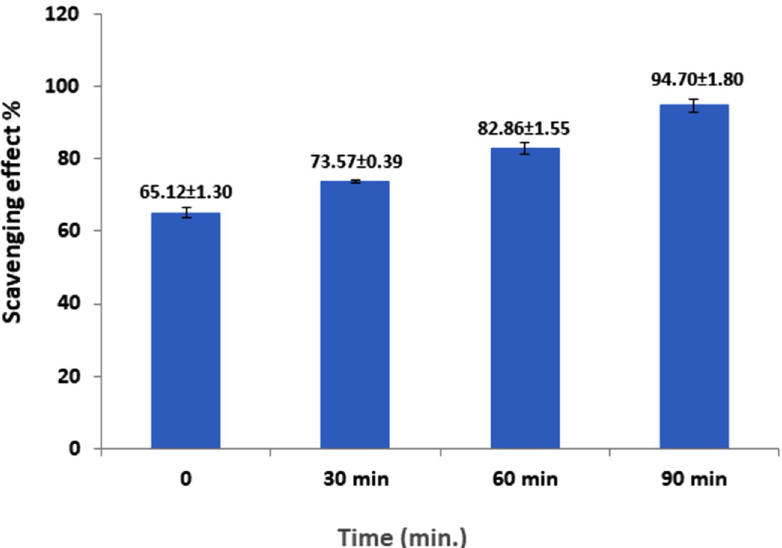
Figure 3. DPPH scavenging activity of the PsPc-3 from Pleurotus